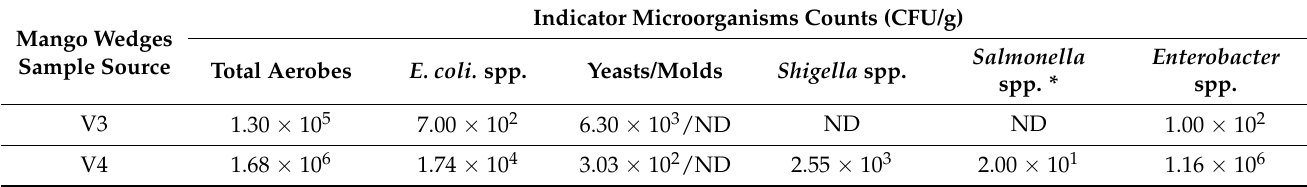
Table 2. Bacteriological analysis of ready-to-eat mango wedges (expressed as CFU/g). Mango